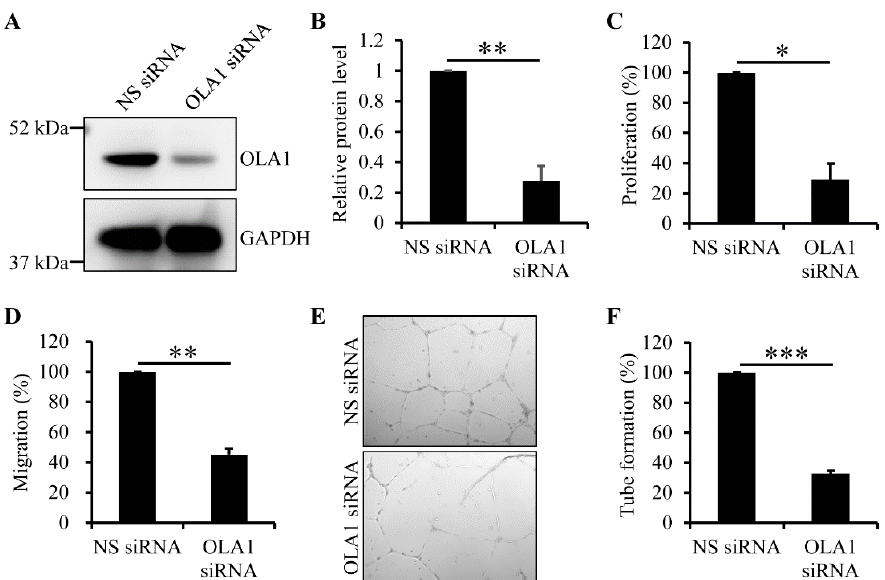
Figure 4. Effect of OLA1 RNAi on proliferation and migration of and tube formation by human aortic ECs. ( A , B ) Depletion of OLA1 in human aortic ECs. After human aortic ECs were transfected with non-silencing (NS) or OLA1 siRNA duplexes for 42 h, cells were collected and lysed for immunoblot analysis with antibodies against OLA1 and GAPDH (loading control). Immunoblot images of both OLA1 and GAPDH are shown in ( A ). The band intensities of OLA1 and GAPDH from ( A ) were determined using LS software from VisionWorks (UVP, LLC). The band intensity of OLA1 was normalized to that of GAPDH, and the relative protein levels of OLA1 normalized to the non-silencing treatment in the graph show in ( B ) are the means ± s.d. (error bars) from four independent experiments. **, p < 5 × 10 − 5 . ( C ) Depletion of OLA1 causes a reduced proliferation of human aortic ECs. After human aortic ECs were transfected with the indicated siRNA duplexes for 42 h, 1.5 × 10 4 cells were incubated with the BrdU-containing medium for 8 h. The BrdU-incorporated cells were stained using 3,3 ′ -diaminobenzidine tetrahydrochloride for analysis. Each independent experiment was duplicated. In the graph, values are the relative percentages of the amounts of incorporated BrdU in cells normalized to the non-silencing treatment and the means ± s.d. (error bars) from three independent experiments. *, p ˂ 5 × 10 − 4 (Student’s t -test). ( D ) Depletion of OLA1 causes reduced migration ability in human aortic ECs. After human aortic ECs were transfected with the indicated siRNA duplexes for 42 h, 3 × 10 4 cells were resuspended in 100 μ L of 0.5% FBS medium for the trans-well assay. The cells stuck in the pores of the filter were imaged and quantitated. Each independent experiment was triplicated. In the graphs, values are the relative percentages of migrating cells nor- malized to the non-silencing treatment and the means ± s.d. (error bars) from three independent experiments. **, p ˂ 5 × 10 − 5 (Student’s t -test). ( E , F ) Depletion of OLA1 causes reduced capillary tube formation by human aortic ECs. After human aortic ECs were transfected with the indicated siRNA duplexes for 42 h, 5 × 10 4 ECs were used for Matrigel tube formation assay (see the Materials and Methods section (Section 4.8)). The formed capillary tubes were imaged as shown in ( E ) and quantitated as shown in ( F ). Each independent experiment was triplicated. In the graph shown in ( F ), values are the relative percentages of the formed capillary tubes normalized to the non-silencing treatment and the means ± s.d. (error bars) from three independent experiments. ***, p ˂ 1 × 10 − 6 (Student’s t -test).